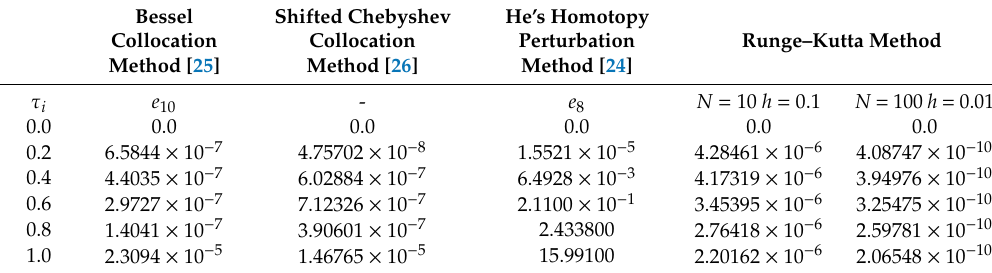
Table 5. Comparing absolute errors for pervious